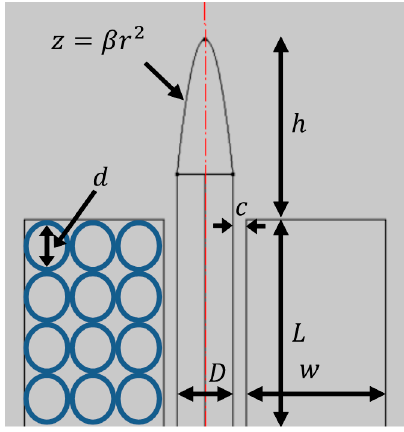
Figure 1. The geometry of an electromagnet with a parabolic pole tip. 𝐿 and 𝑤, length and width of the windings area; 𝑑 , wire diameter; 𝐷 , magnetic pole diameter; 𝑐 , core sleeve’s width; 𝛽 , parabolic curvature of the pole tip; and h , the distance from the coil edge to the pole’s tip. We evaluated cylindrical magnetic poles ( 𝐷 = 12.7 mm) with four different tip shapes: A flat, a cone, a paraboloid, and a cube (Figure 2). The magnetic field profile of each pole was simulated assuming an electromagnet with the following parameters: 𝐿 = 100 mm, 𝑤 = 31.7 mm, ℎ = 35